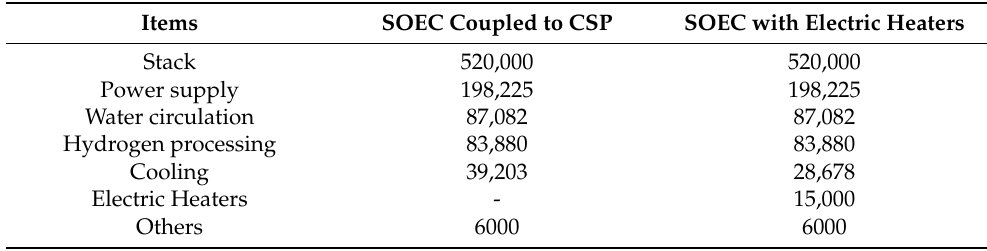
Table 4. SOEC electrolyzer plant capital costs values in [$]